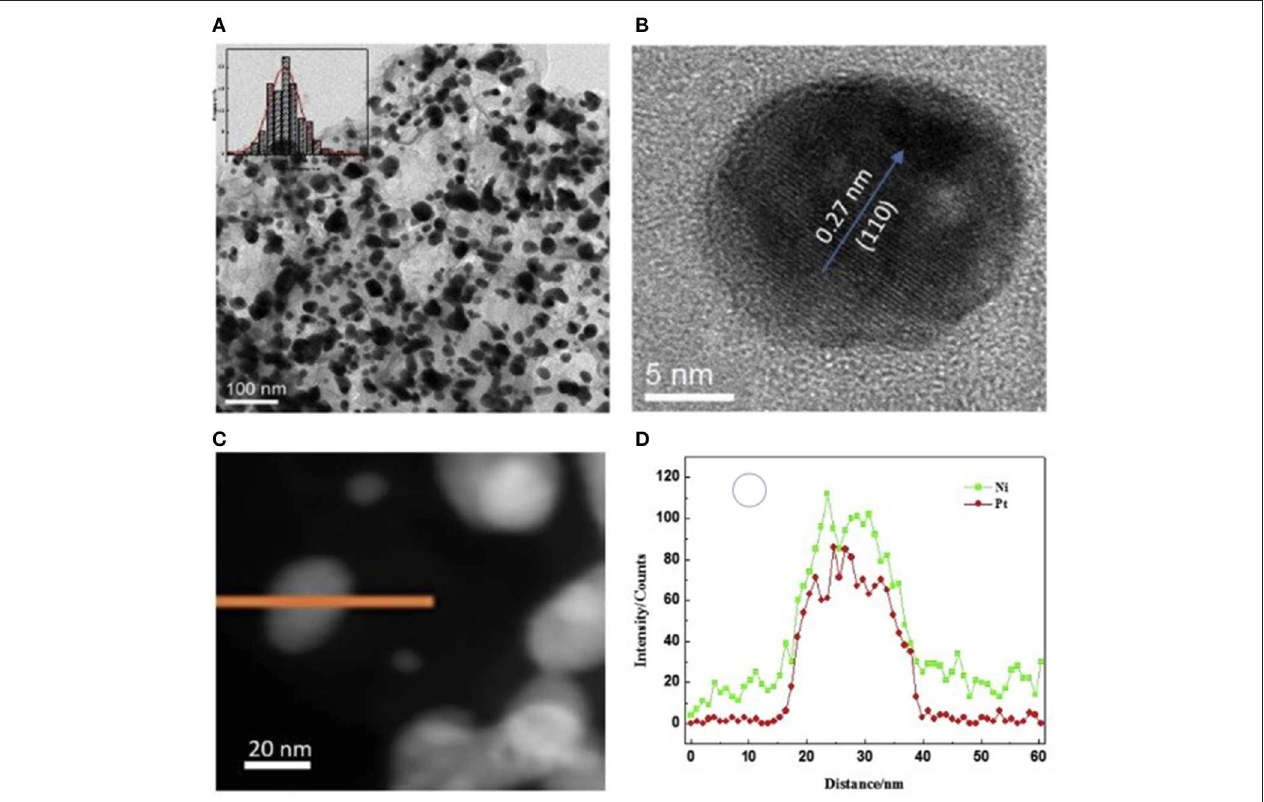
FIGURE 3 | (A) TEM image, and the inset is the particle size distribution of PtNi NPs for PtNi/CA; (B) HRTEM image of a single PtNi NP; (C) EDS line scan of one PtNi NP and (D) Pt, Ni distribution. Reprinted from Wang et al. (2017b), © 2017, with permission from